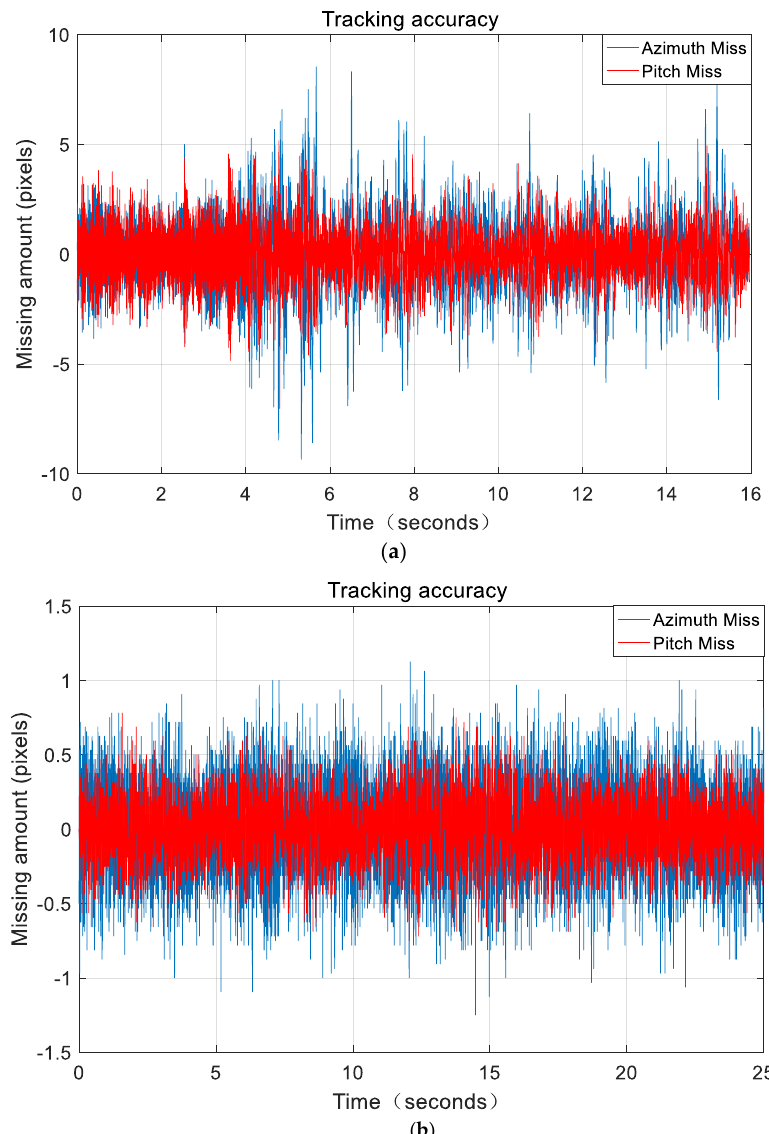
Figure 12. Comparative test of tracking accuracy of the azimuth and pitch axis of a UAV in flight. ( a ) FSM is controlled by existing algorithm; ( b ) FSM is controlled by digital decoupling and resonance suppression.